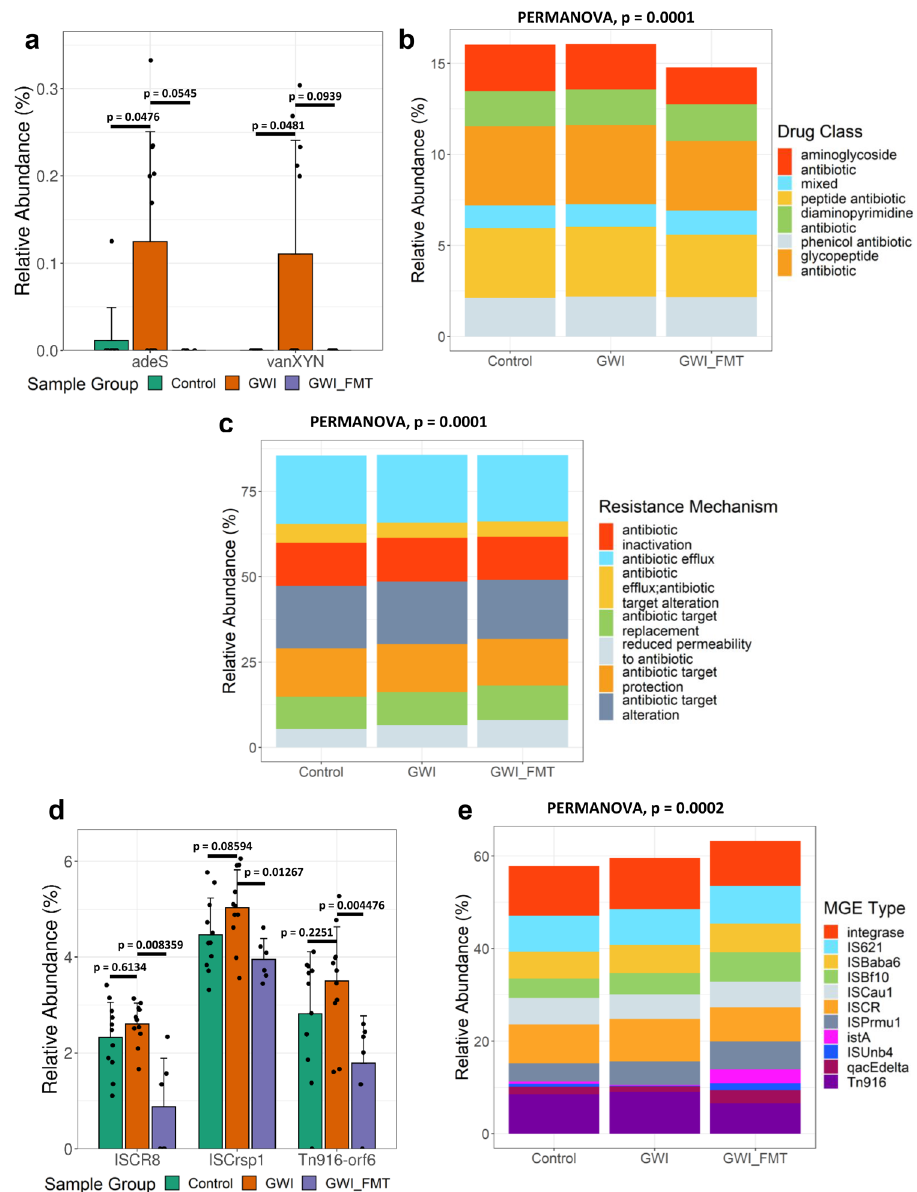
Fig. 2 Classi fi cation of selected ARGs and MGEs in persistence GWI mouse model. a Grouped bar graph showing relative abundance (%) of selected ARGs in Control (adult C57BL/6 J mice administered with vehicle, n = 11 biologically independent samples), GWI (adult C57BL/6 J mice administered with GW chemicals, n = 11 biologically independent samples), and GWI_FMT (adult C57BL/6 J mice group exposed to GW chemicals followed by FMT treatment, n = 6 biologically independent samples) groups. Stacked bar analysis of relative abundance (%) of b drug classes resistances and c mechanisms of resistance. d Grouped bar graph showing relative abundance (%) of selected MGEs in Control, GWI and GWI_FMT groups. e Stacked bar analysis of relative abundance (%) of MGE types. Data represented as Mean±SD (SD: Standard deviation) for the bar graphs. p -values were determined using Wald ’ s test or PERMANOVA where p < 0.05 was considered statistically signi fi